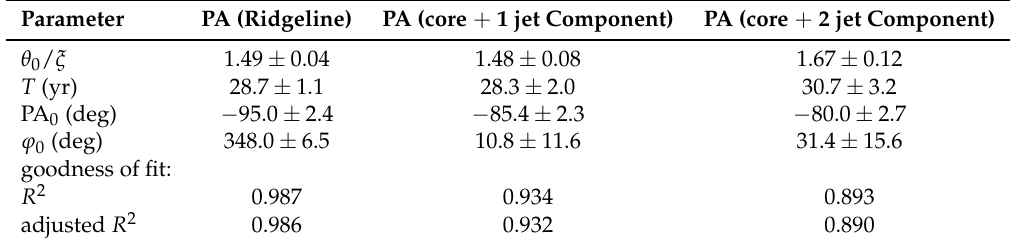
Table 1. Parameters of the helical jet derived from an approximation of the observed PA in .